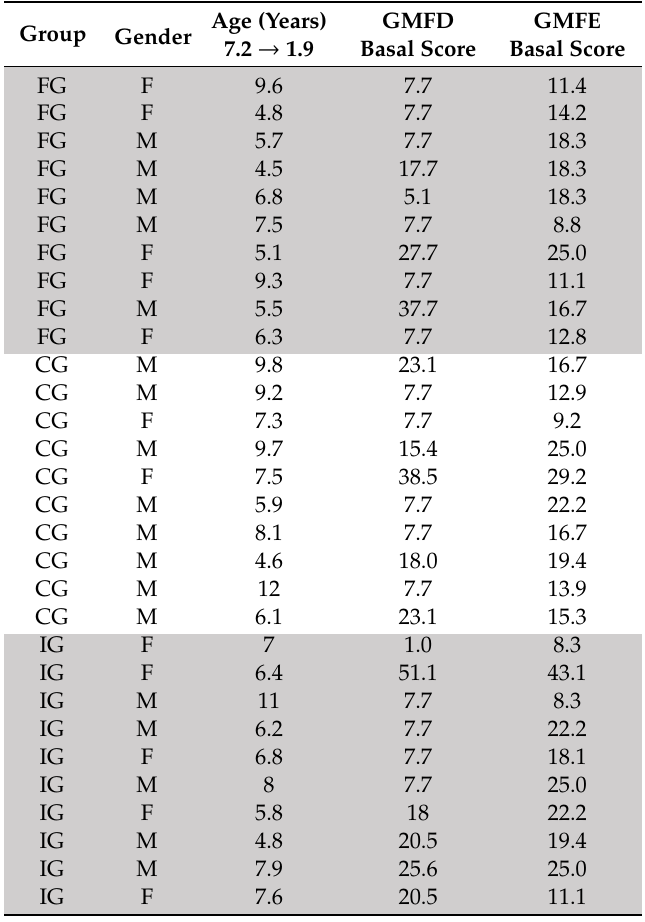
Table 1. Clinical characterization of patients with cerebral palsy